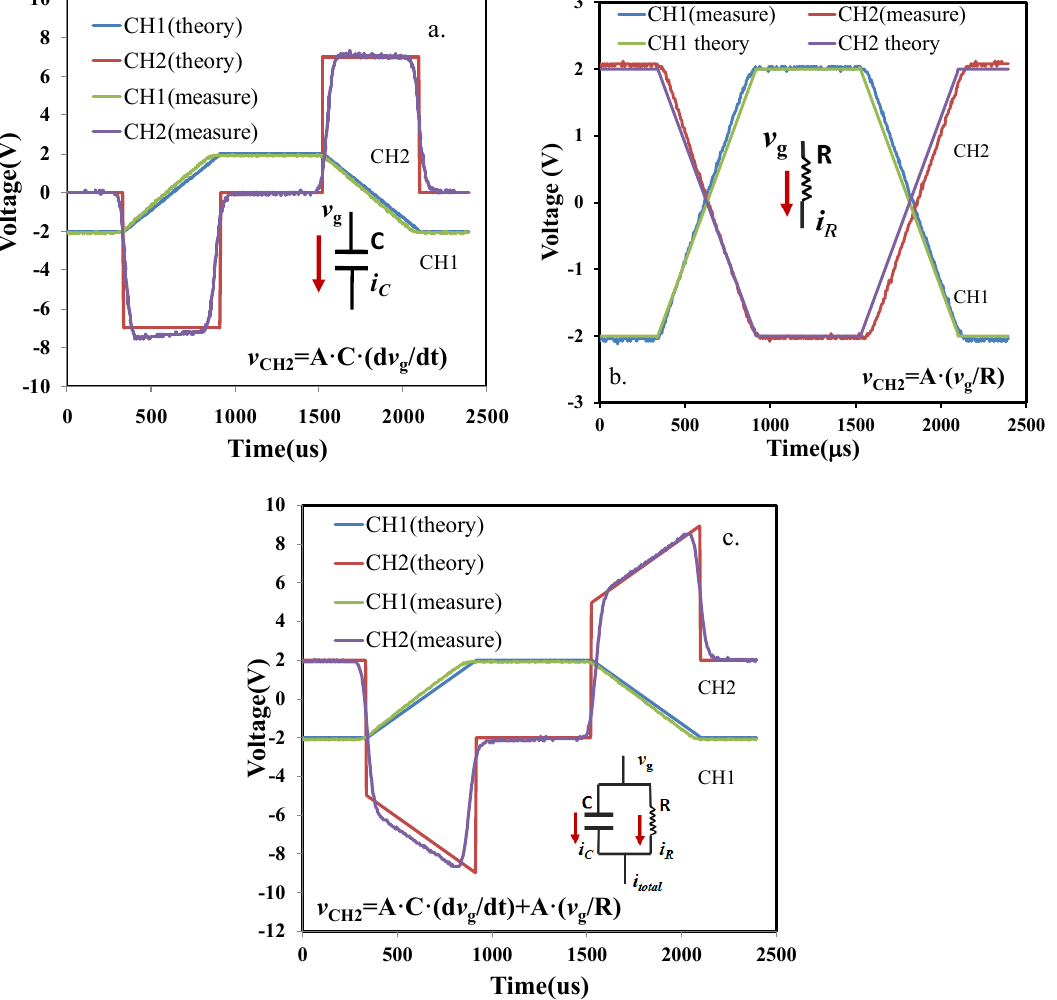
Figure 2. ( a ) Voltage (V) versus time (μs) of a discrete capacitor. ( b ) Voltage (V) versus time (μs) of a discrete resistor. ( c ) Voltage (V) versus time (μs) of a discrete